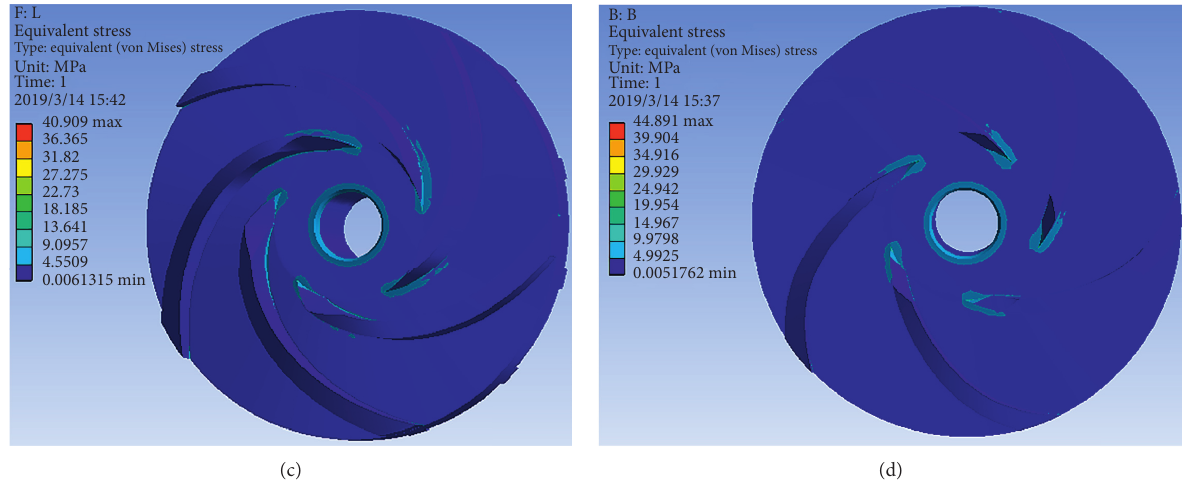
Figure 20: Equivalent stress of the impellers. (a) Single arc. (b) Double arc. (c) Logarithmic spiral. (d) B-spline